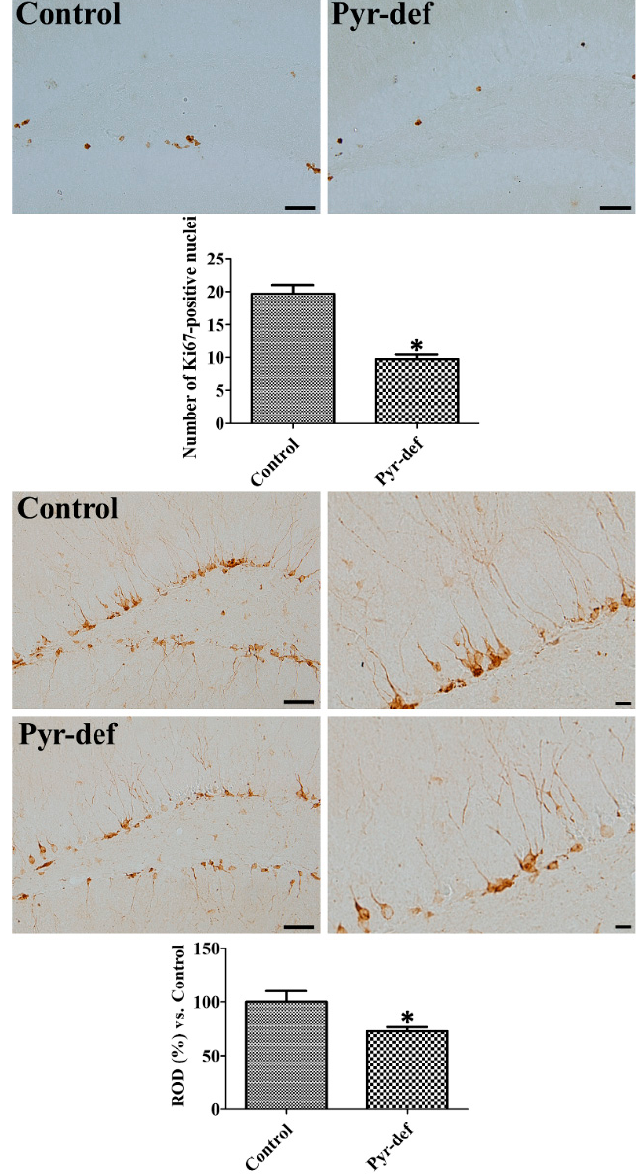
Figure 2. Pyridoxine deficiency (Pyr-def) decreases Ki67-positive proliferating cells and doublecortin- (DCX) immunoreactive neuroblasts in the dentate gyrus.